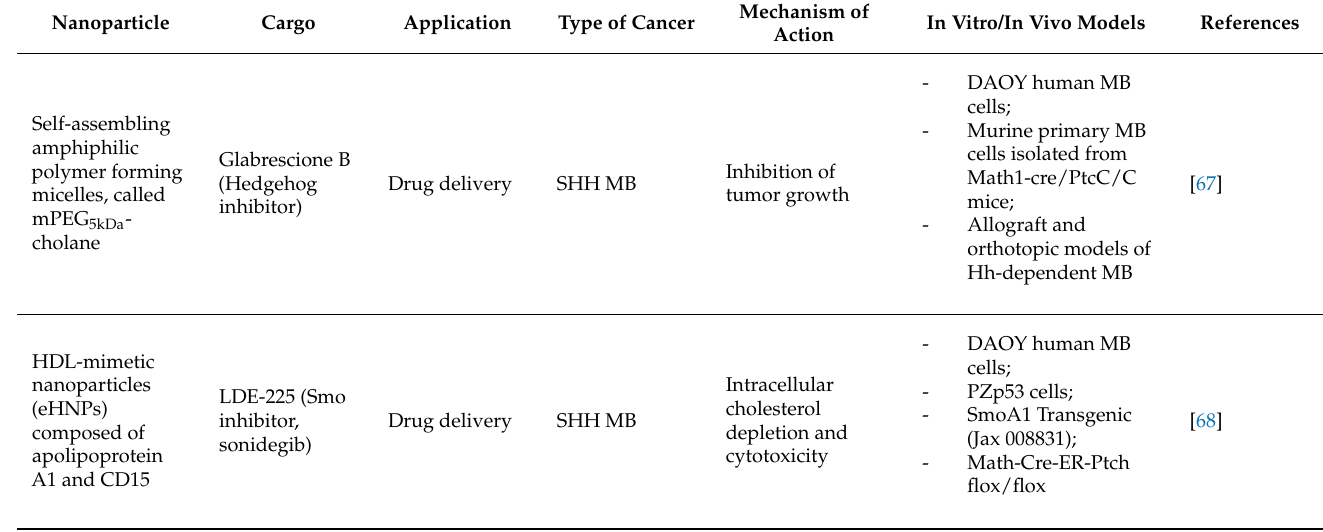
Table 2. Examples of different types of NPs used in pediatric brain tumor models. List of NPs and cargoes used to target brain tumor